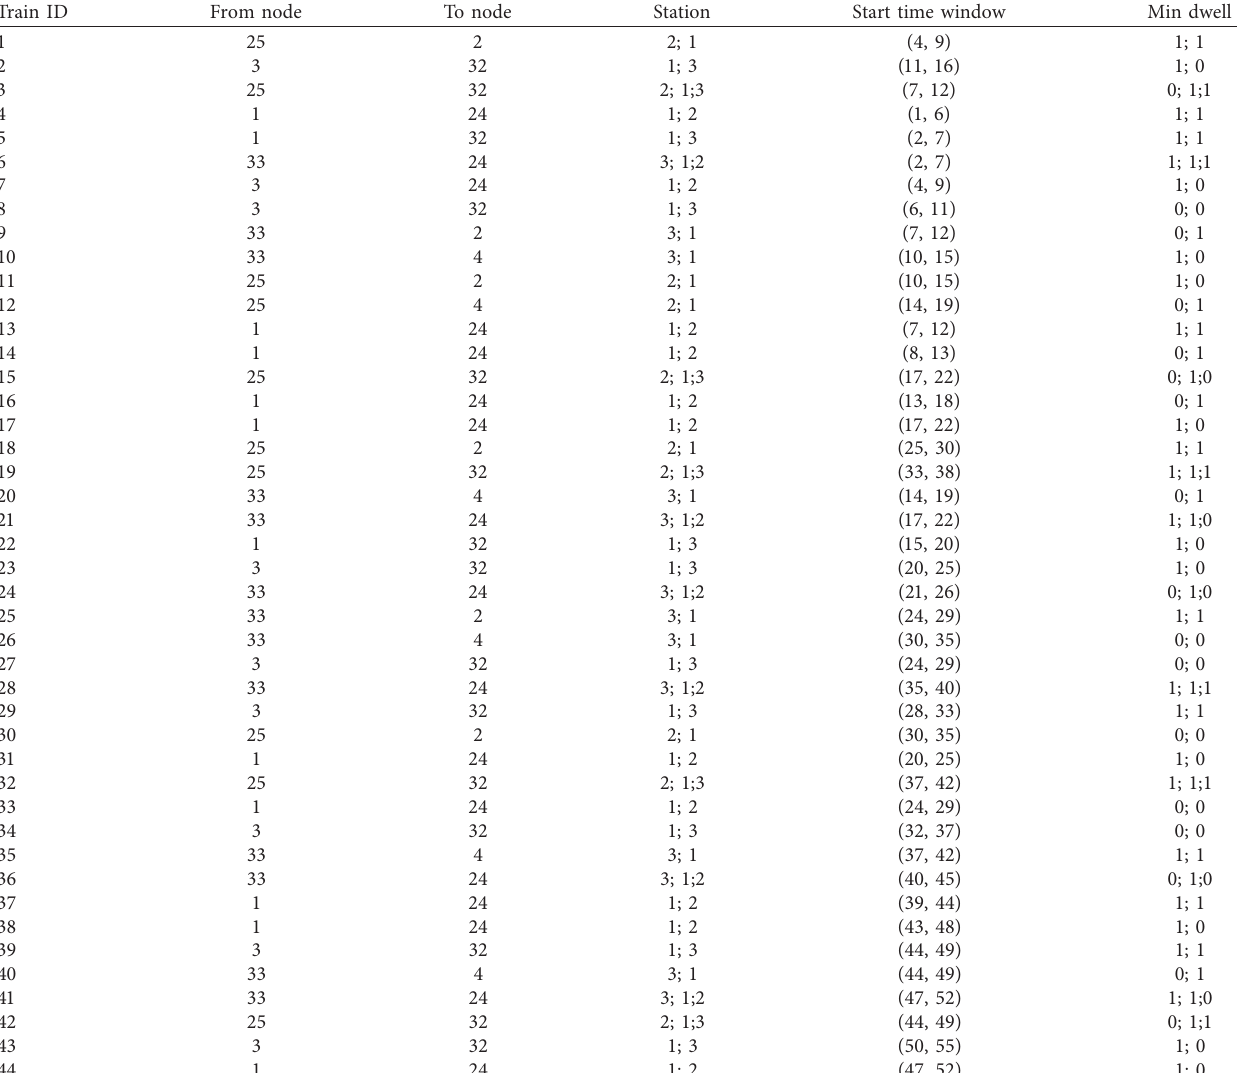
Figure 6: Three-station network with 37 nodes and 66 physical links. Table 4: Train data for small railway